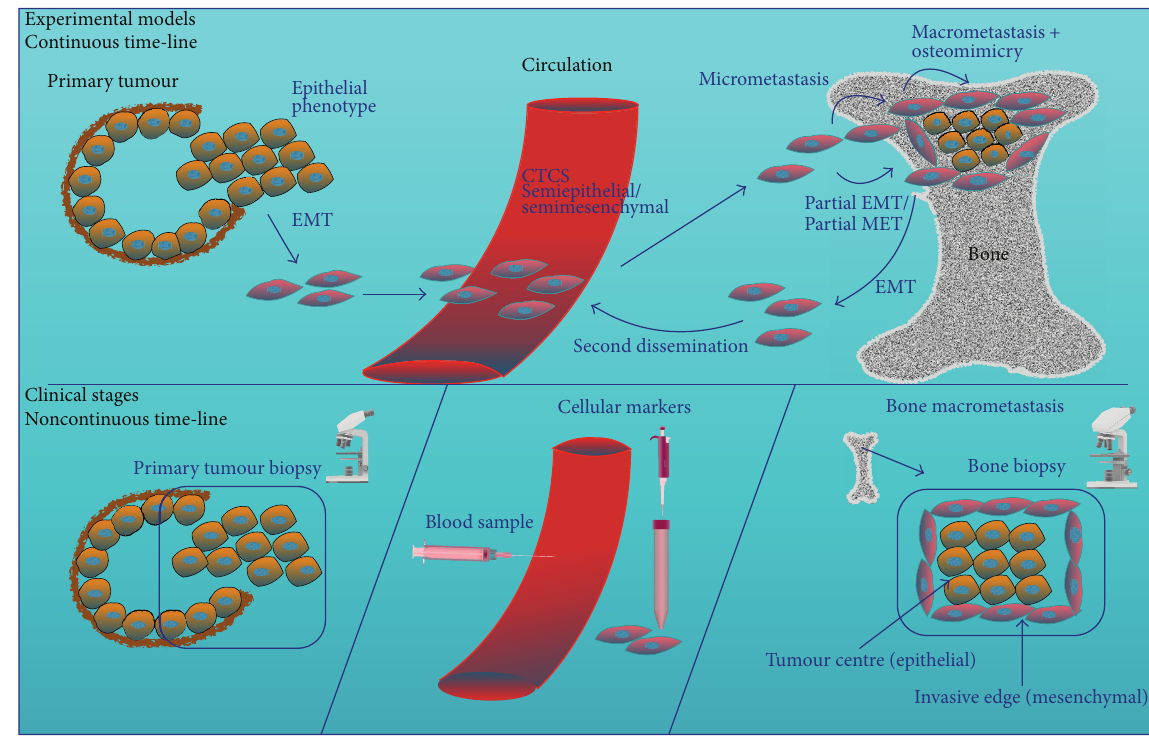
Figure 2: Cellular plasticity of prostate cancer cells over time. The plasticity of cancer cells over time can be delineated from experimental animal and in vitro models. Cells in the primary tumour undergo EMT, which enhances their migratory and invasive potential. These invasive cells enter the circulation and may exist as mesenchymal, epithelial, or semimesenchymal/semiepithelial circulating tumour cells (CTCs). Extravasation of CTCs into the bone gives rise to micrometastases. As the metastatic tumour cells colonise the bone and grow into macrometastasis,cellswithinthetumourcentreundergoMETtoenabletumourgrowthandsurvivalunderhypoxia,whilecellsattheinvasive edge retain their mesenchymal phenotype to enable invasiveness and osteomimicry. It is suggested that these phenotypic changes are partial and that metastatic cells can dynamically transition between these two states to allow for adaptation to altered microenvironmental stimuli and for further invasion and secondary dissemination. Clinical samples, on the other hand, represent observations of established primary masses and macrometastases at static points in time. Therefore, they cannot capture the dynamic nature of cellular plasticity. Furthermore, current CTC-detection techniques are epithelial-based and cannot capture CTCs that are mostly mesenchymal and have reduced expression of epithelial markers, which would result in missing a significant fraction of CTCs that are predominantly in the mesenchymal